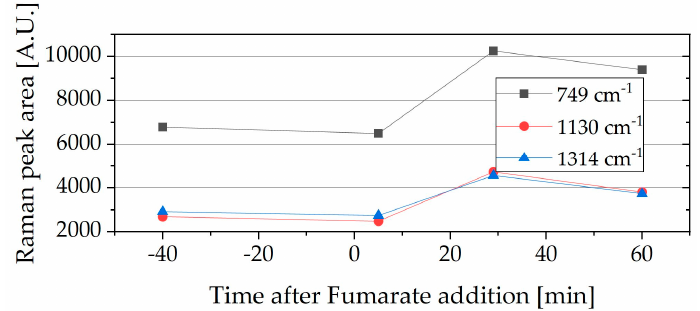
Figure 4. Raman peak area of one Δ pilA sample where fumarate was almost consumed and after the addition of additional fumarate (Raman peak areas: 1314 cm − 1 ▲ , 1130 cm − 1 ● , 749 cm − 1 ■ ), (1.5 mM fumarate, 5.4% of initial, and 10 mM acetate, 50 h into the cultivation).